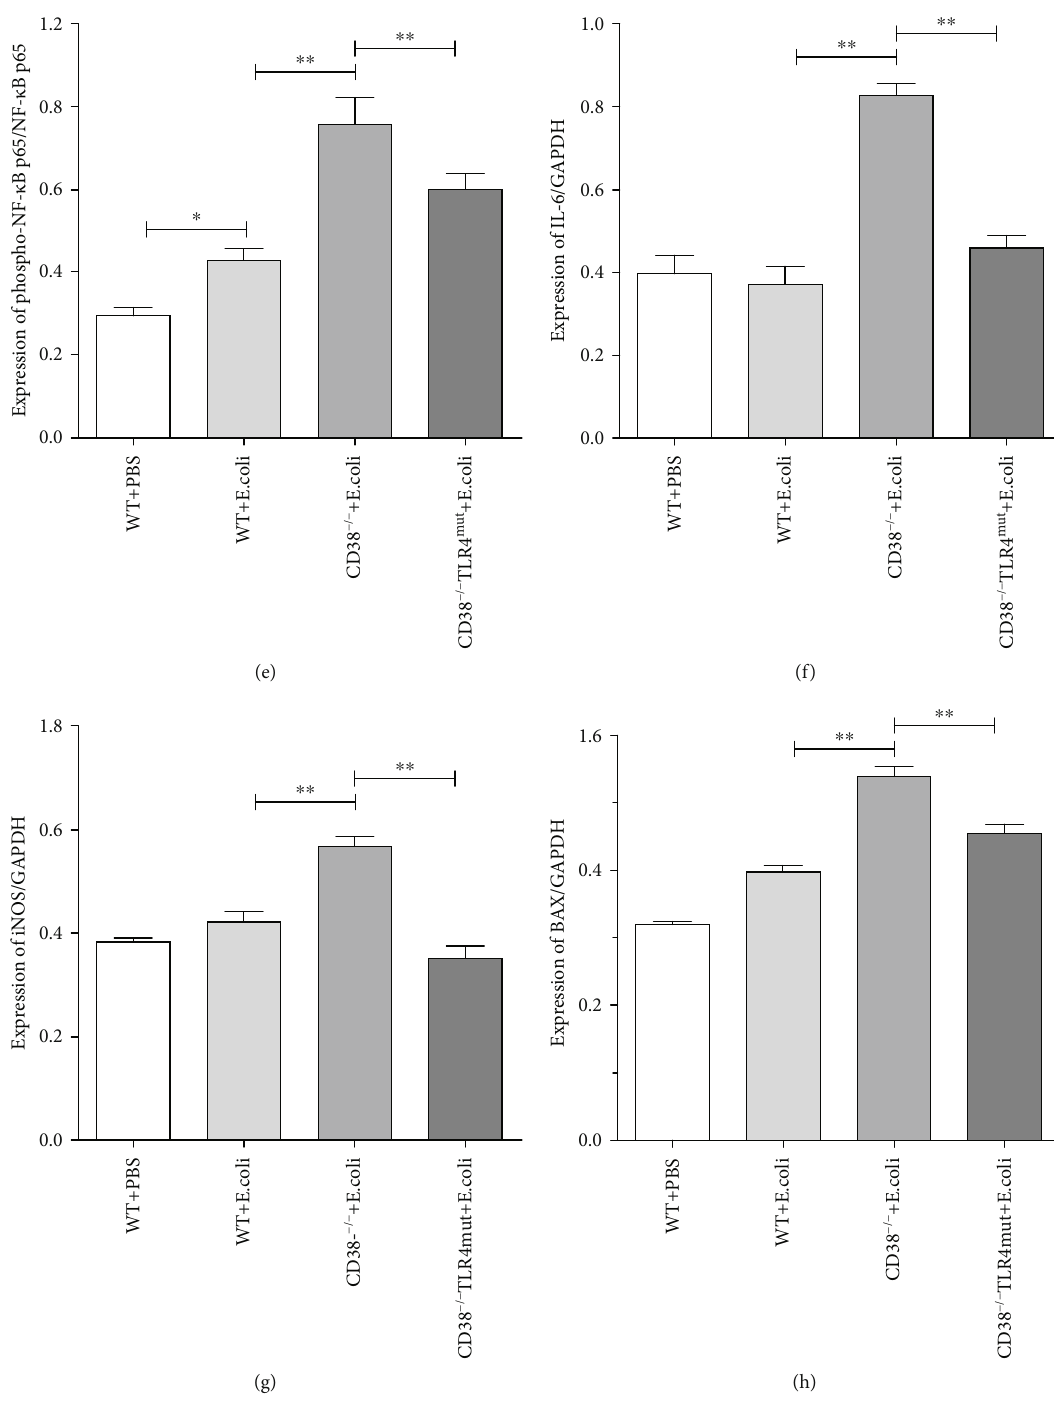
Figure 3: Expression of TLR4-NF- κ B and in fl ammatory cytokines in the liver was detected by Western blot. Changes in expression of liver TLR4 and proin fl ammatory cytokines in WT, CD38 -/- , and CD38 -/- TLR4 mut mice were detected at 3 hours after E. coli stimulation by Western blot. The expressions of TLR4, MyD88, TRIF, NF- κ B p65 and phospho-NF- κ B p65, IL-6, iNOS, and BAX were measured (a). And relative levels of TLR4 to GAPDH (b), MyD88 to GAPDH (c), TRIF to GAPDH (d), phospho-NF- κ B p65 to NF- κ B p65 (e), IL-6 to GAPDH (f), iNOS to GAPDH (g), and BAX to GAPDH (h) were analyzed by ImageJ software. Data are presented as means ± standard deviation . Statistical signi fi cance was determined by one-way ANOVA ( n = 3 , ∗ p < 0 : 05 , ∗∗ p < 0 : 01